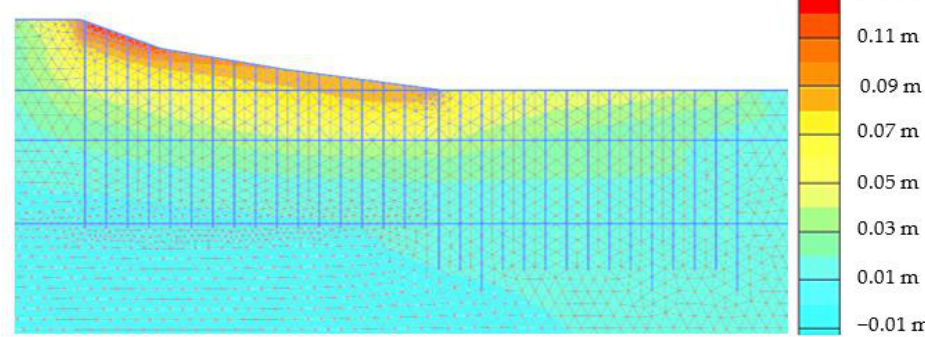
Figure 11. FEA of the TE waveform: Residual displacement.